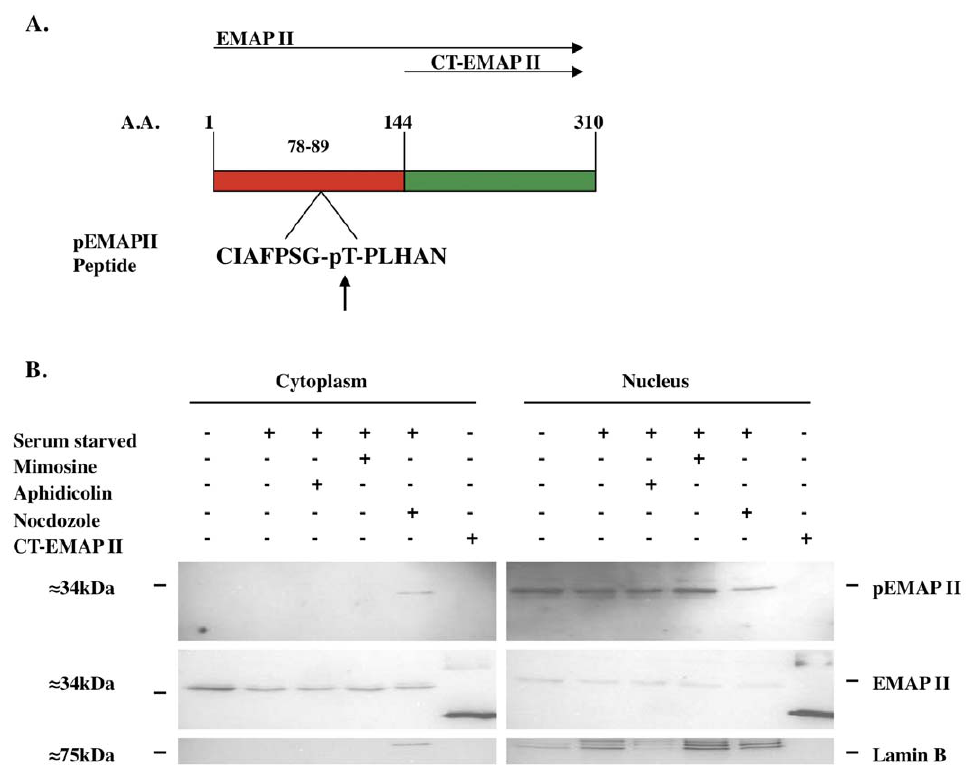
Figure 7. Phosphorylated EMAP II is predominately localized in the nuclear fraction. A phosphorylated pThr84-EMAP II antibody was obtained (A) and phospo-EMAP II was examined in nuclear and cytoplasmic fractions during cell cycle. Phospho-EMAP II was found in the nuclear fraction G0-S phase of cell cycle with only the phosphorylated form found in the cytoplasm during G2M. Unphosphorylated EMAP II (capable of recognizing unphosphorylated and phosphorylated EMAP II) was confined to the cytoplasm as only a single band corresponding with the phosphorylated form was found in the nuclear isolates (B). Lamin B nuclear envelope confirmed nuclear isolate specificity (these experiments were performed a minimum of 4